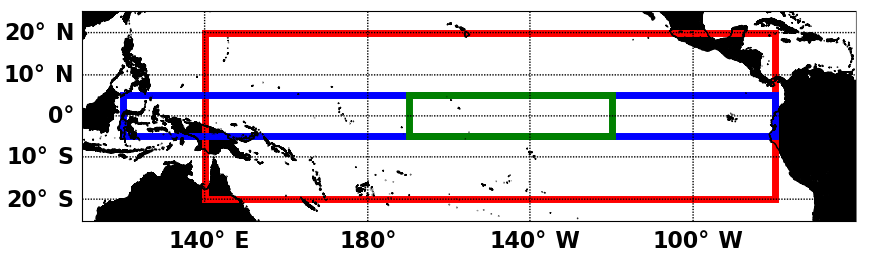
Figure 1. Pacific area (red rectangle) from 140–280 ◦ E to 20 ◦ S–20 ◦ N, the NINO3.4 area (green rectangle) from 170–120 ◦ W to 5 ◦ S–5 ◦ N and the WWV area (blue rectangle) from 120–280 ◦ E to 5 ◦ S–5 ◦